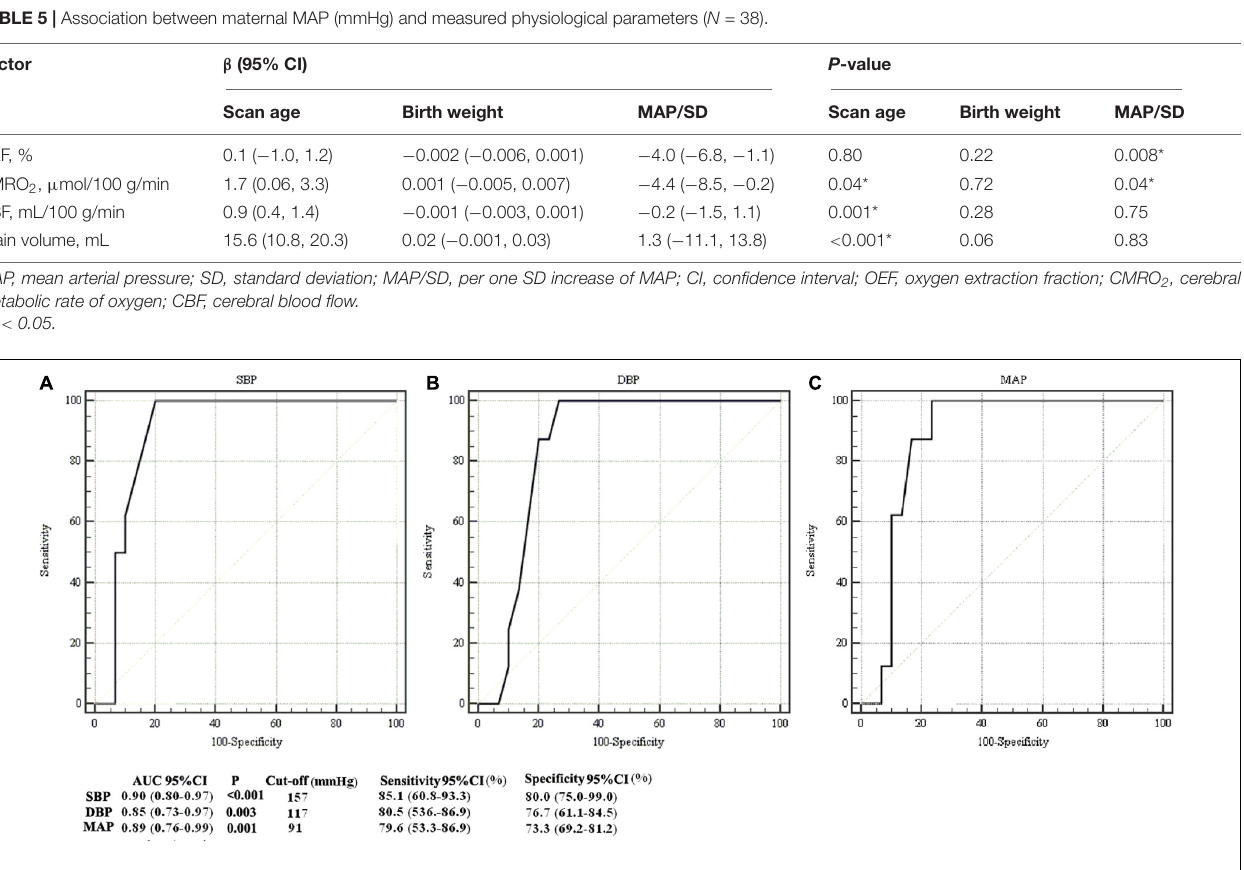
FIGURE 5 | Comparison of ROC curves in identifying newborns with abnormal structural MRI. ROCs for analysis of the association between maternal systolic blood pressure (SBP) and neonatal brain injury on structural MRI (A) , between maternal diastolic blood pressure (DBP) and neonatal brain injury on structural MRI (B) , and between maternal mean arterial pressure (MAP) and neonatal brain injury on structural MRI (C) . The areas under curves (AUCs) for SBP, DBP and MAP were 0.90 [confidence interval (CI): 0.80–0.97], 0.85 (0.73–0.97), and 0.89 (0.76–0.99),